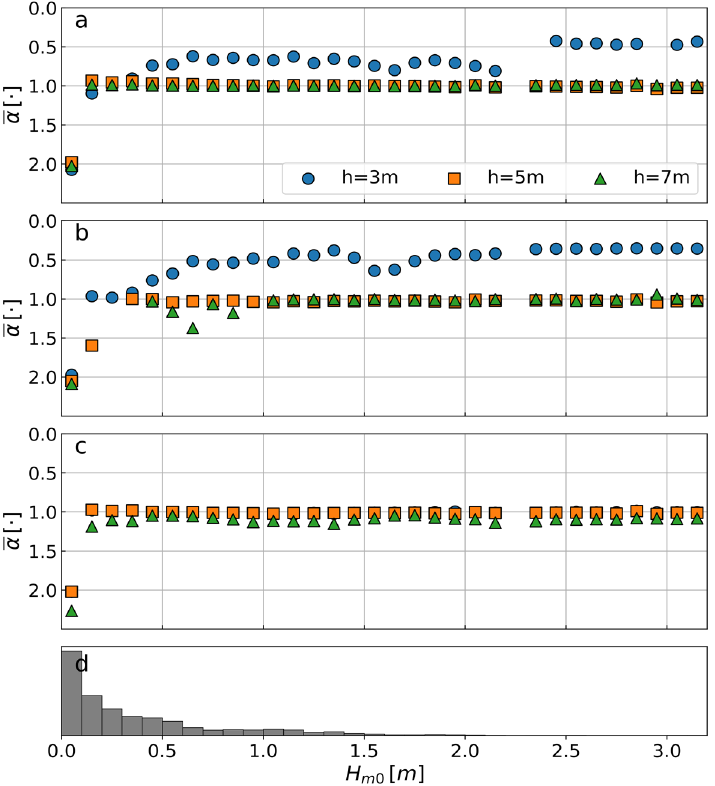
Figure 10. Relative integrated wave power binned by offshore wave height for the Ogden Dunes regional scenario where the blue circles, orange squares, and green triangle markers represent the 3 m, 5 m, and 7 m placement depths, respectively. ( a ) Linear berm; ( b ) undulated berm; ( c ) discrete mounds; ( d ) probability density function for offshore wave height.